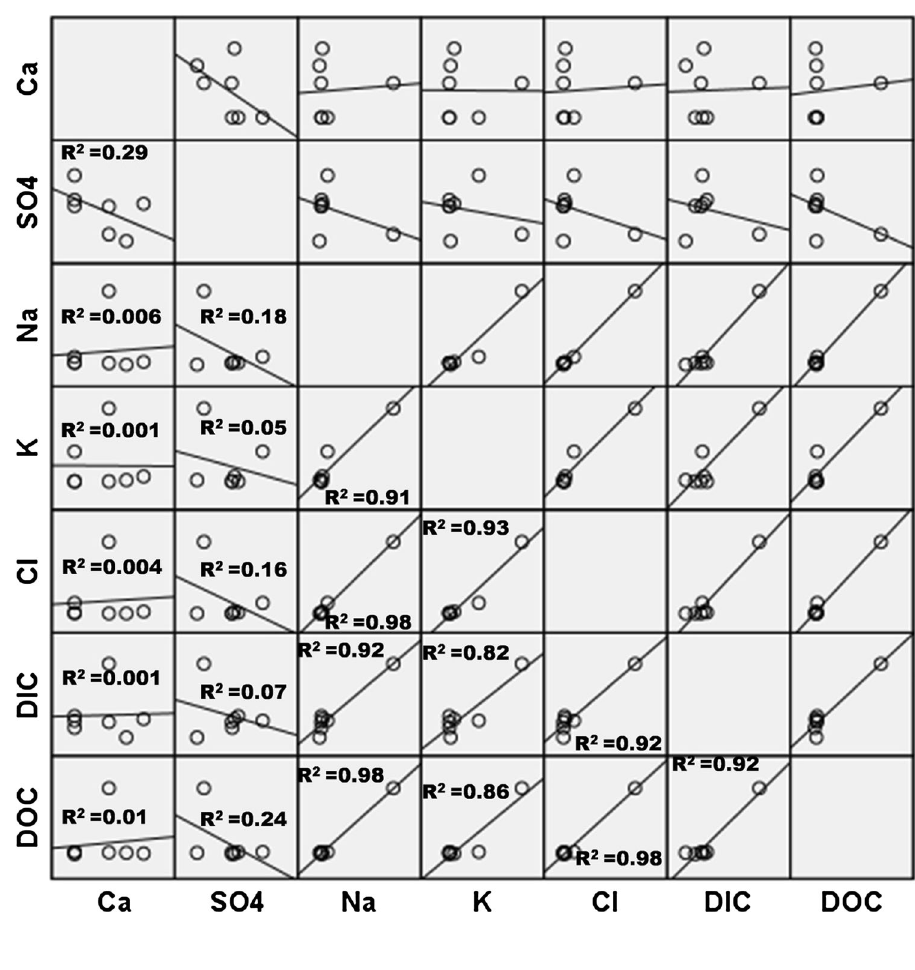
Fig. 6 Diagram showing correlations during POM